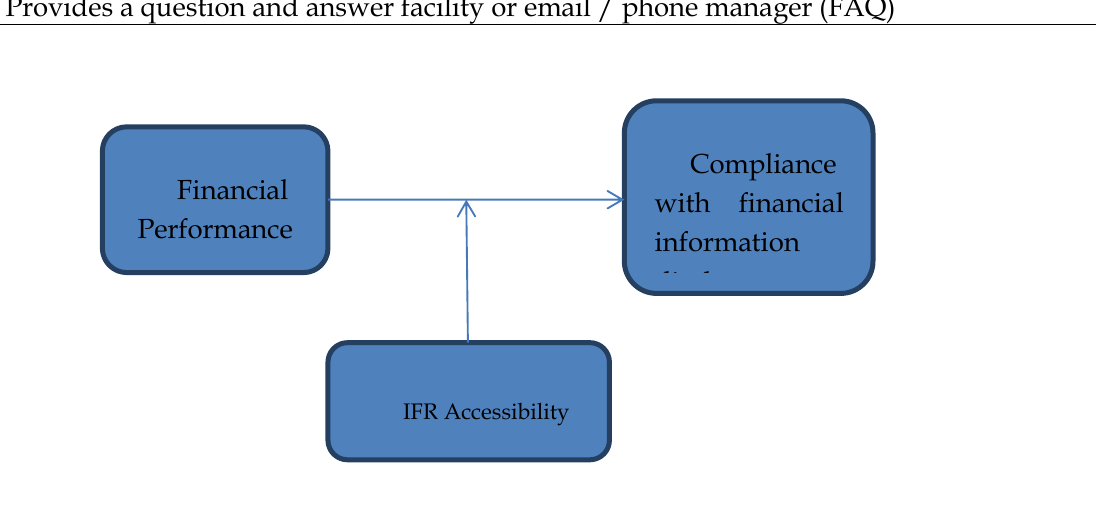
Figure 1: Research Variable